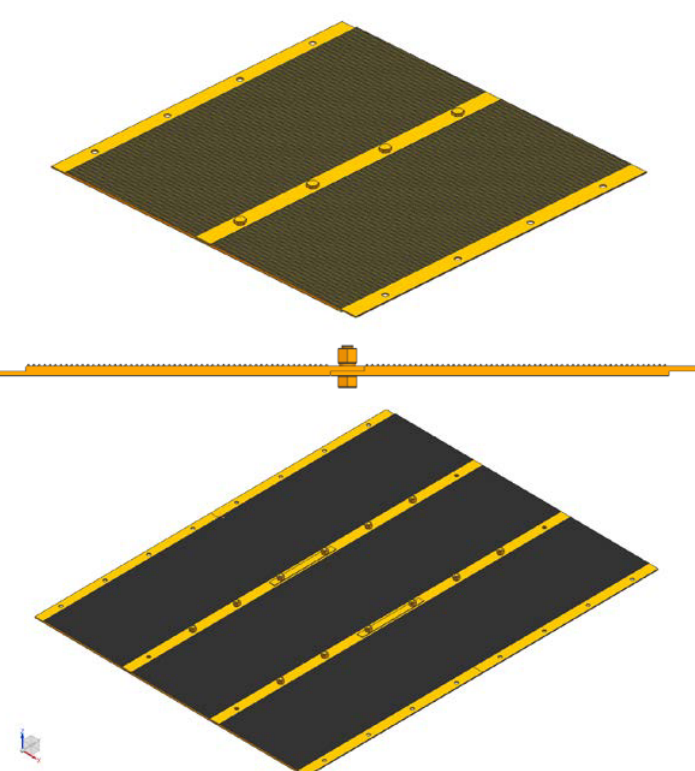
Fig. 6. Bottom layer module connection